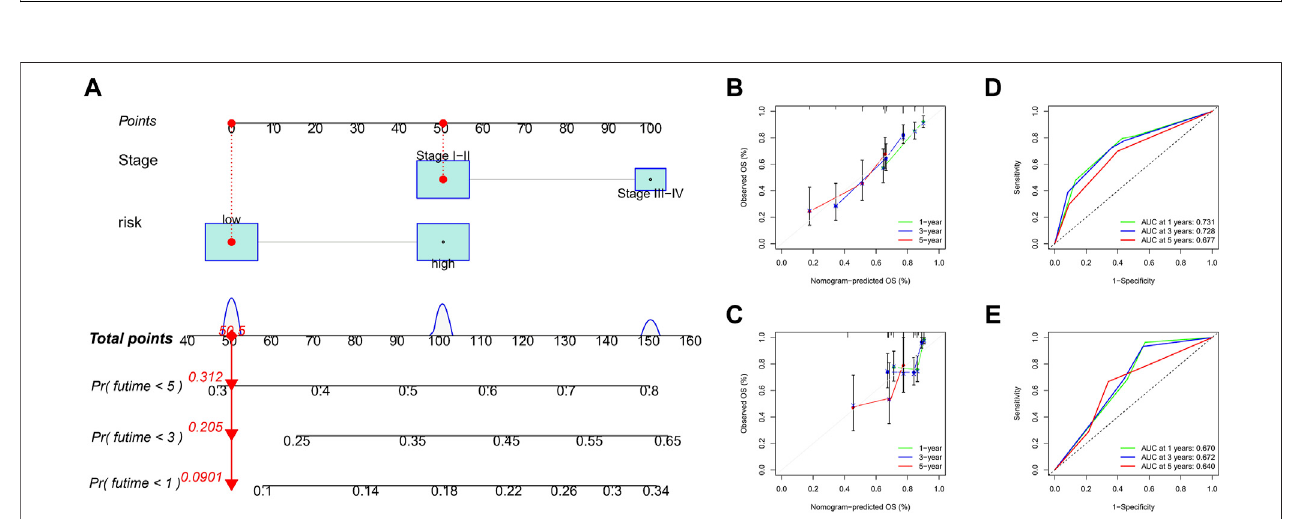
FIGURE7| Constructionandvalidationofnomogram. (A) ThenomogramintegratedtheriskscoreandTNMstagetopredictthesurvivalrateofthe1,3,and5 years. (B,C) The 1, 3, and 5 years OS calibration curves for the TCGA (B) and ICGC (C) cohorts. (D,E) The 1, 3, and 5 years ROC curves of the TCGA (D) and ICGC (E) cohorts.